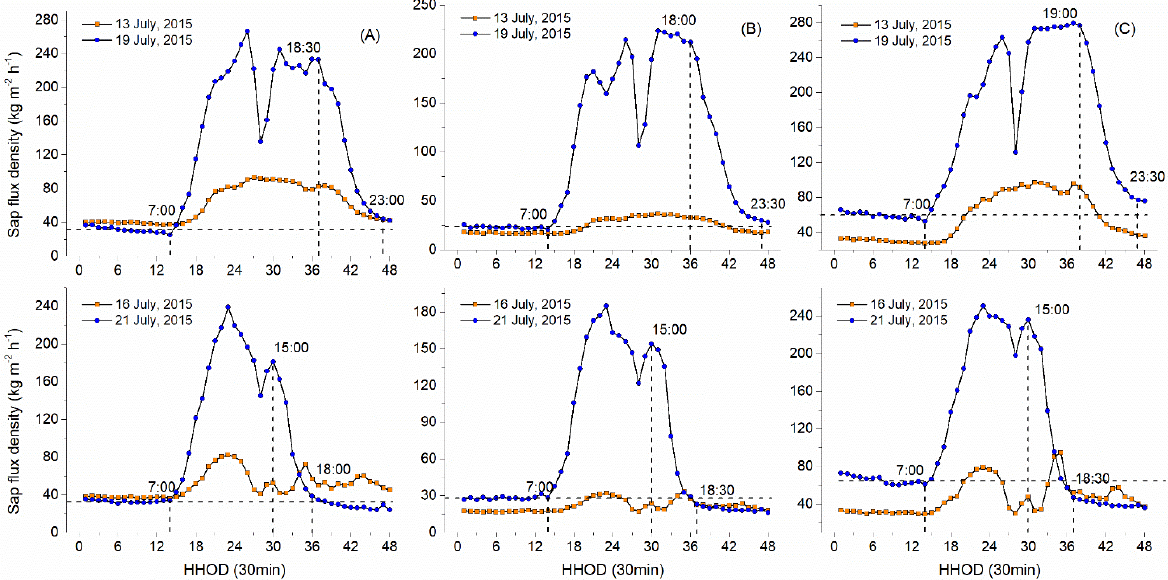
Figure 5. A daily course of sap flux density activity for 2 days with similar weather conditions during July 2015. The DBHs of columns ( A – C ) were DBH2, DBH3, and DBH4,